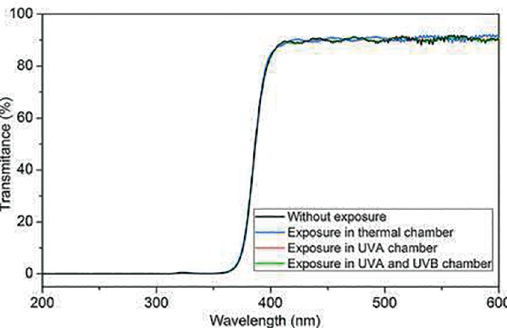
Figure 8. UV-Vis spectra for the polymeric film for UV protection without exposure and with exposure to the test conditions for 1000